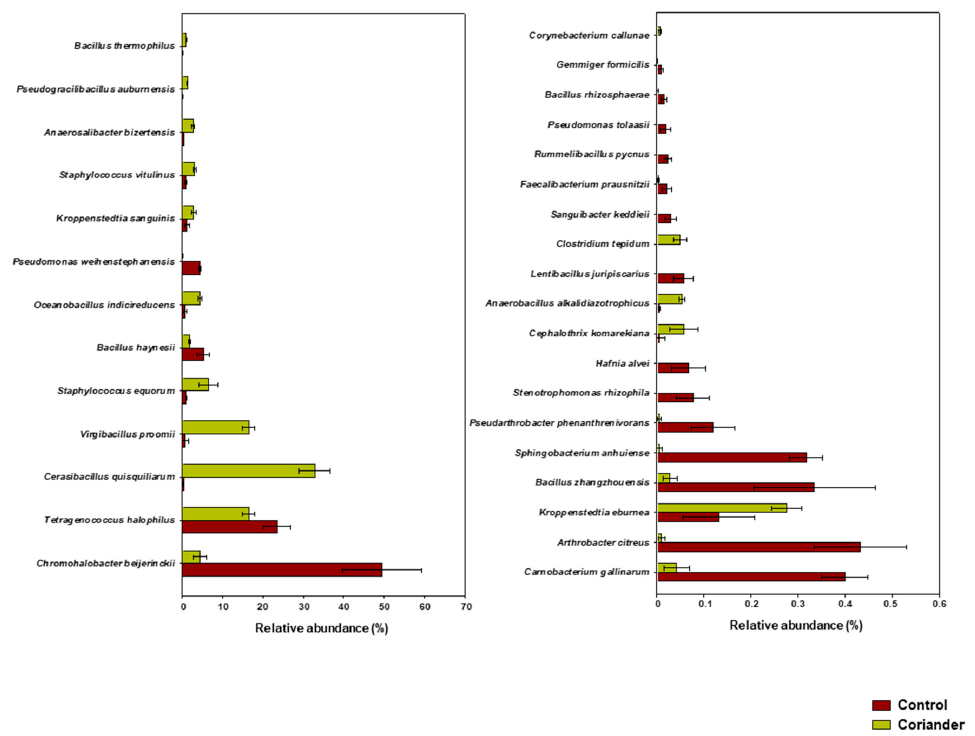
Figure 4. Bacterial species existing with significantly different ( p < 0.05) relative abundance in soy sauce samples prepared by adding coriander, compared to those in control. Bars represent means and standard deviations.